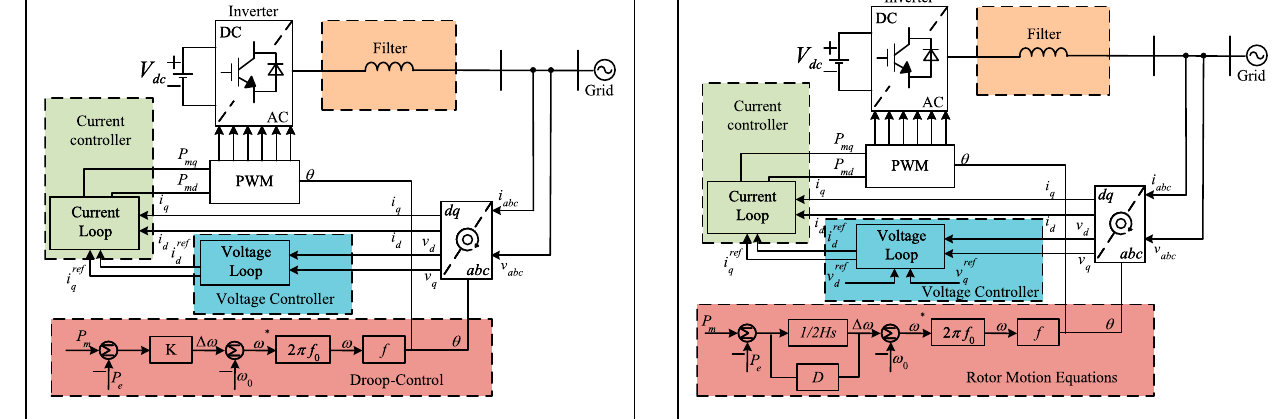
FIGURE 2 | Control block diagram of droop-control. FIGURE 3 | Active support control block